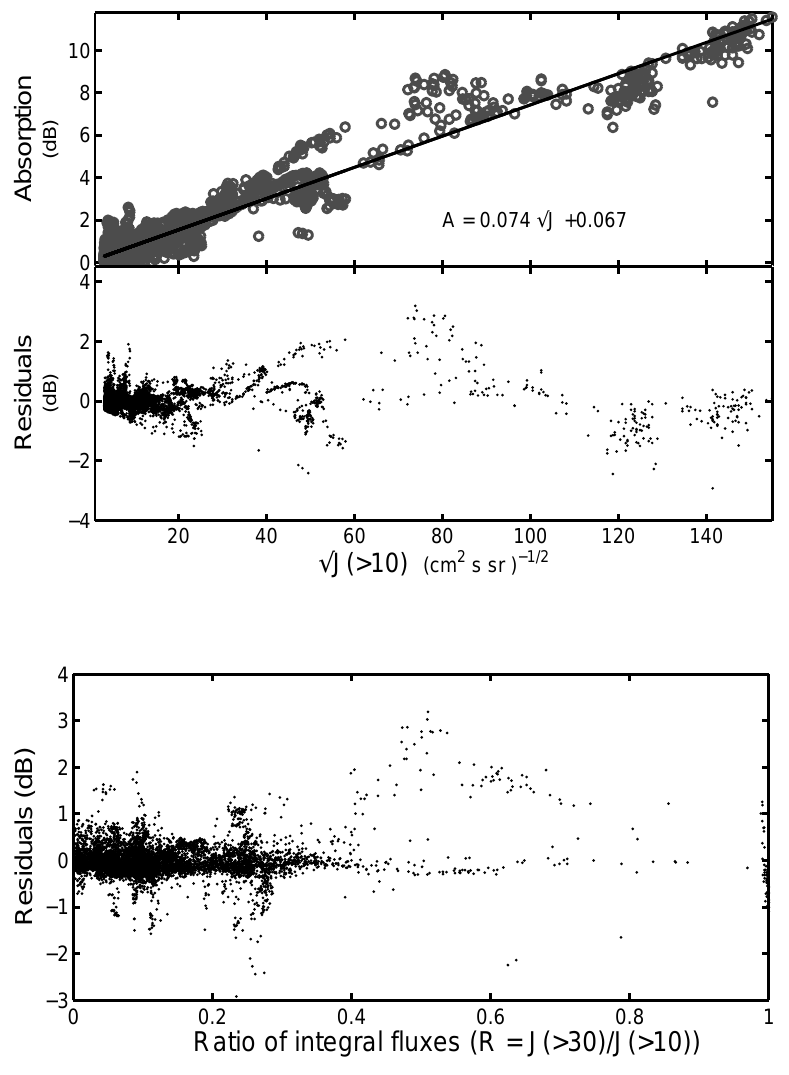
Fig. 7. Residuals of the fit plotted as a function of the ratio: R = J(> 30 ) to J(> 10 ) . R provides a simple in- dication of the hardness of the spec- trum of precipitation by determining how much of the > 10MeV protons are also > 30MeV. A spread of absorption lies below R = 0 . 3; the bulk of the resid- uals are between ± 1dB ( ≈ 85%). There is no readily apparent trend in the resid- uals that suggests consistently higher errors at larger values of R